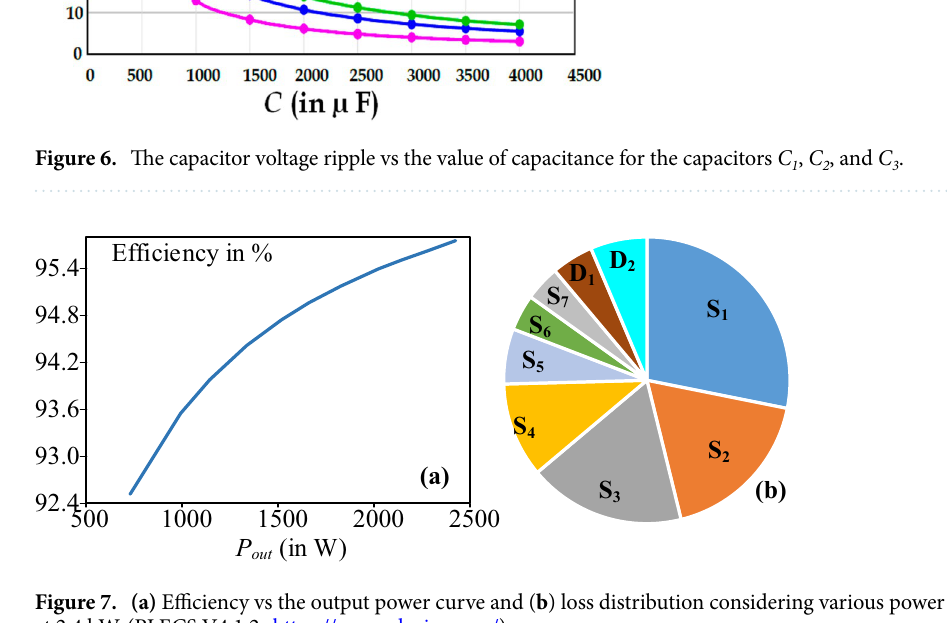
Figure 7. (a) Efficiency vs the output power curve and ( b ) loss distribution considering various power switches at 2.4 kW. (PLECS V4.1.2- https:// www. plexim.